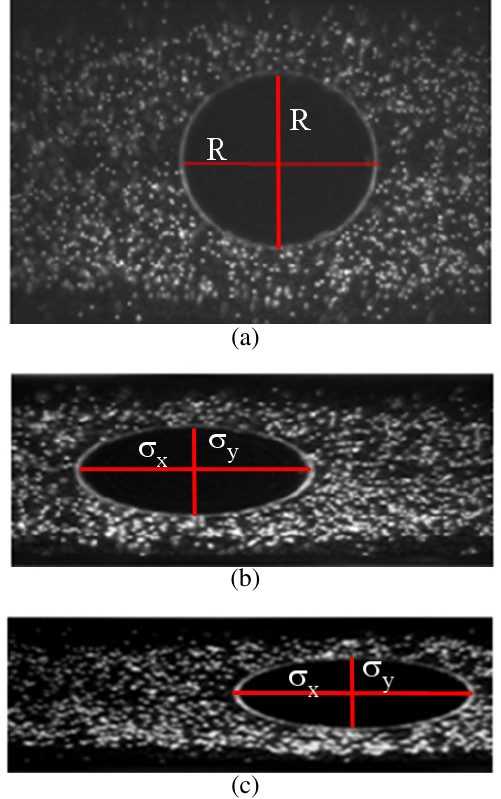
Fig. 3. (Color online) Bubble images recorded at CCDs: (a) normal mode, (b) 2 × 1 vertical binning mode, (c) 3 × 1 vertical binning